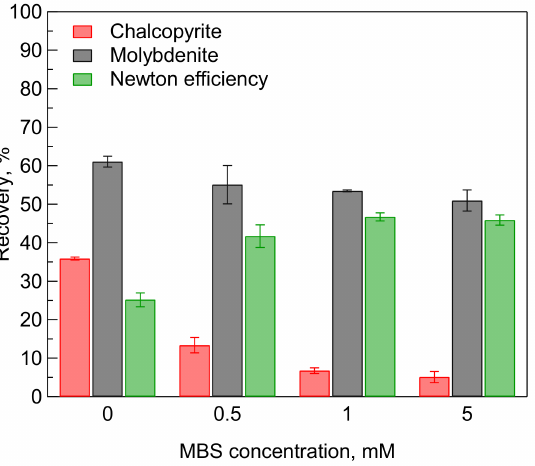
Figure 5. Effect of sodium metabisulfite (MBS) on the recovery of mixed chalcopyrite and molybdenite (1:1 ratio) in the absence of a collector at pH